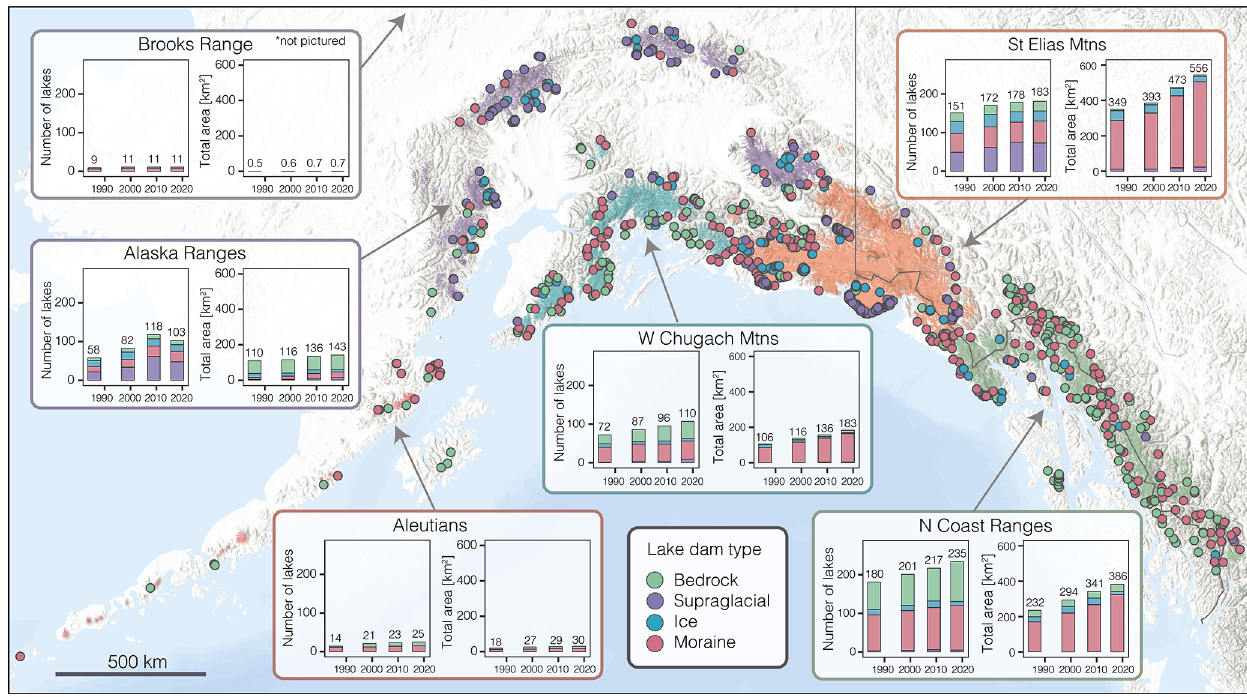
Figure 8. Dam type distribution (spatial, frequency, and total area) for each Alaska subregion. Note Brooks Range is not pictured on the map; see Fig. 1. Basemap provided by ESRI (2009). Table 3. Number of lakes, glacierized area, debris-covered area, percent debris cover, normalized lake frequency, normalized lake area, normalized lake area change, and specific glacier mass balance (from Jakob et al., 2021) per subregion. Region No. of Total Total Total Percent Normalized Normalized Normalized Specific mass lakes glacier debris lake debris lake freq. lake area lake area balance 2016–2019 area cover area cover (no. per (km 2 per change (km 2 (mw.e.yr − 1 ) (km 2 ) (km 2 ) (km 2 ) 100km 2 100km 2 per 100km 2 ice) ice) ice) Brooks Range 11 346 10.3 NA Alaska Ranges 103 16278 3135.5 143.0 25 1912 198.7 107 12052